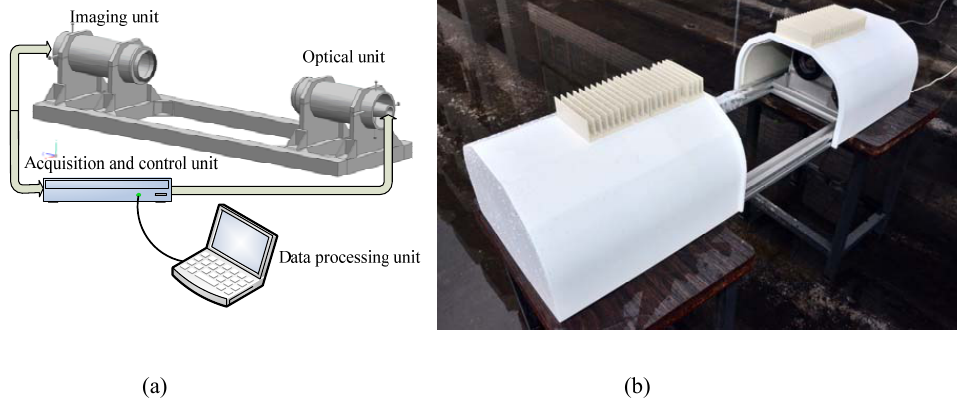
Figure 1. The Framework of VPS equipment and a photograph of the prototype VPS.